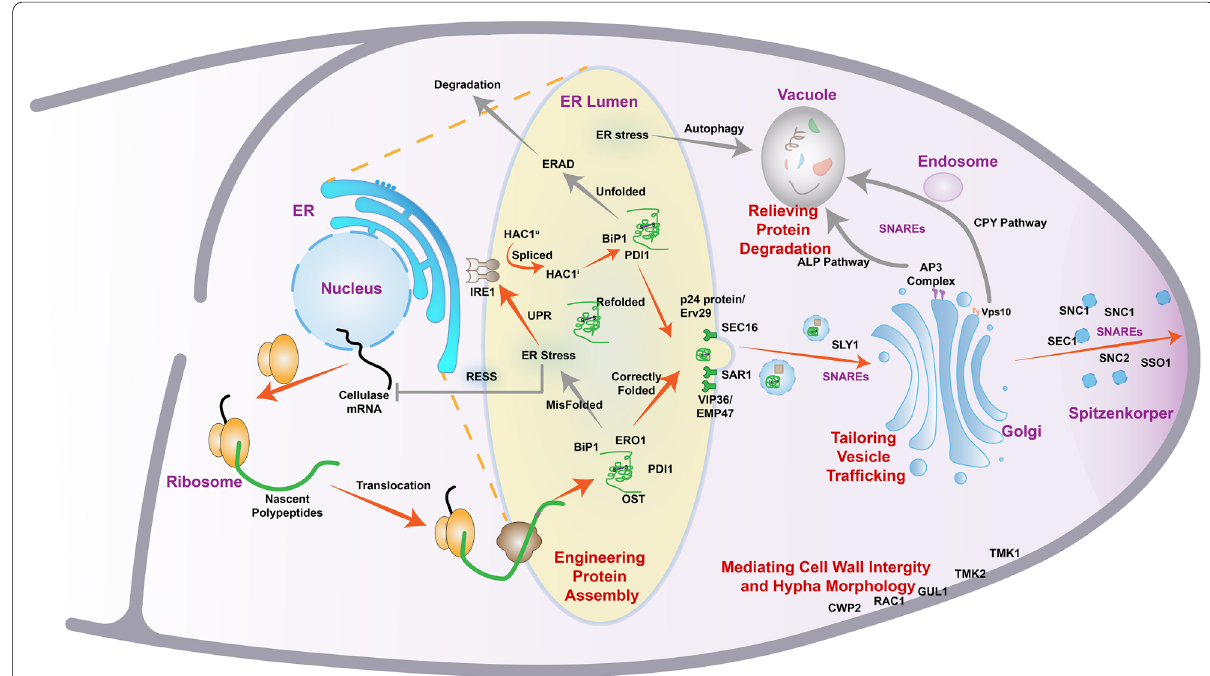
Fig. 3 Secretion pathway in T. reesei . Secreted cellulase will enter the classical secretion pathway, which passes through the ribosome, endoplasmic reticulum, Golgi, and secrets extracellularly. The ER lumen is amplified to give a comprehensive review of the protein assembly and ER quality control. The basic pathway for cellulase secretin is annotated as red arrow, with the assistance of multiple factors, including the PDI1, BiP1, HAC1, SNC1, etc. Insufficient folding or degradation of the secreted protein is indicated by gray arrows. Moreover, the promising secretion factors for improved cellulase production in T. reesei are also annotated aside, which need further exploration. The cellular structures are marked by purple, and the promising secretion pathways for engineering are shown with red